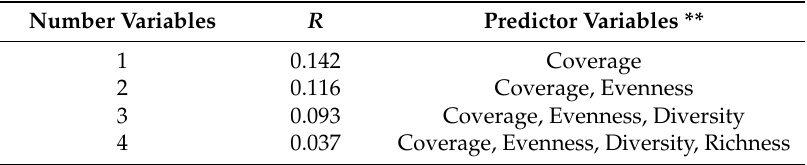
Table 4. Results from the BEST model for each number of predictor variables.